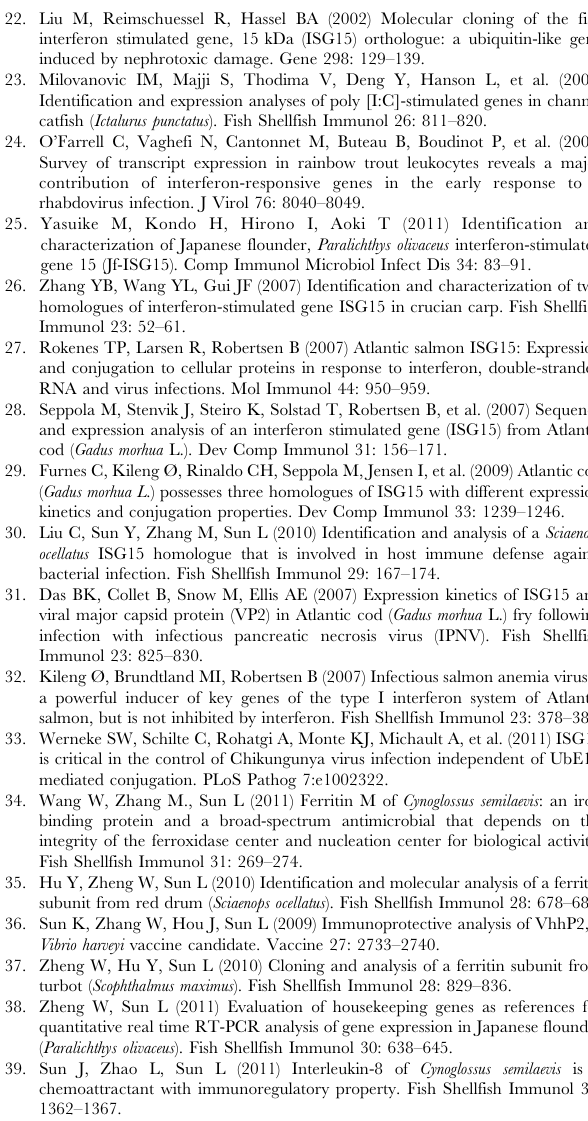
Figure S2 Western blot analysis of the specificity of anti-rCsISG15 antibodies. rCsISG15 (lane 2) and rCsFerM (lane 3) were subjected to SDS-PAGE (upper panel) or immunoblot analysis with antiserum against rCsISG15 (lower panel). Lane 1, protein marker. (TIF) Figure S3 Alignment of the amino acid sequences of ISG15 homologues. Dots denote gaps introduced for maximum matching. Numbers in brackets indicate overall sequence identities between CsISG15 and the compared sequences. The residues that are conserved among all the aligned sequences are in black; the residues that are $ 75% identical among the aligned sequences are in grey. The GenBank accession numbers of the aligned sequences are as follows: Oplegnathus fasciatus (BAJ16365), Epinephelus coioides (AEG78371), Paralichthys olivaceus (BAI48419), Sebastes schlegelii (BA G72218), Anoplopoma fimbria (ACQ57871), Channa argus (ABK63 480), Sciaenops ocellatus (ADJ57326), Oncorhynchus mykiss (NP_0 01118081), Salmo salar (NP_001117112), Gadus morhua (ABD